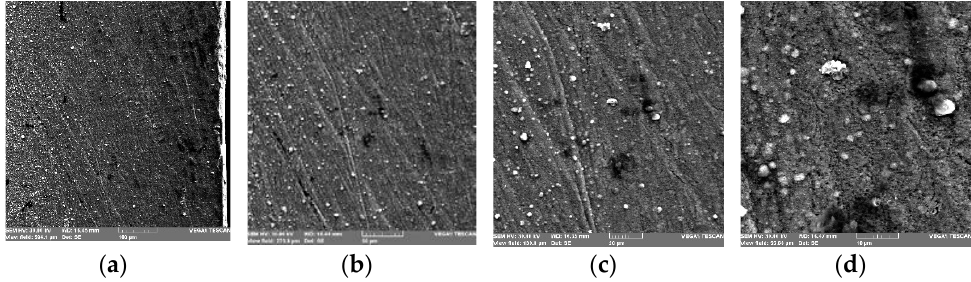
Figure 12. Microstructures of the ionic nitrided structure without the polarized screen, in the area adjacent to the 30° edge, at the top of the prismatic section, and a distance of 40 mm from the base of the part. SEM images at different magnifications: ( a ) 500×, ( b ) 1000×, ( c ) 2000×, and ( d ) 5000×.